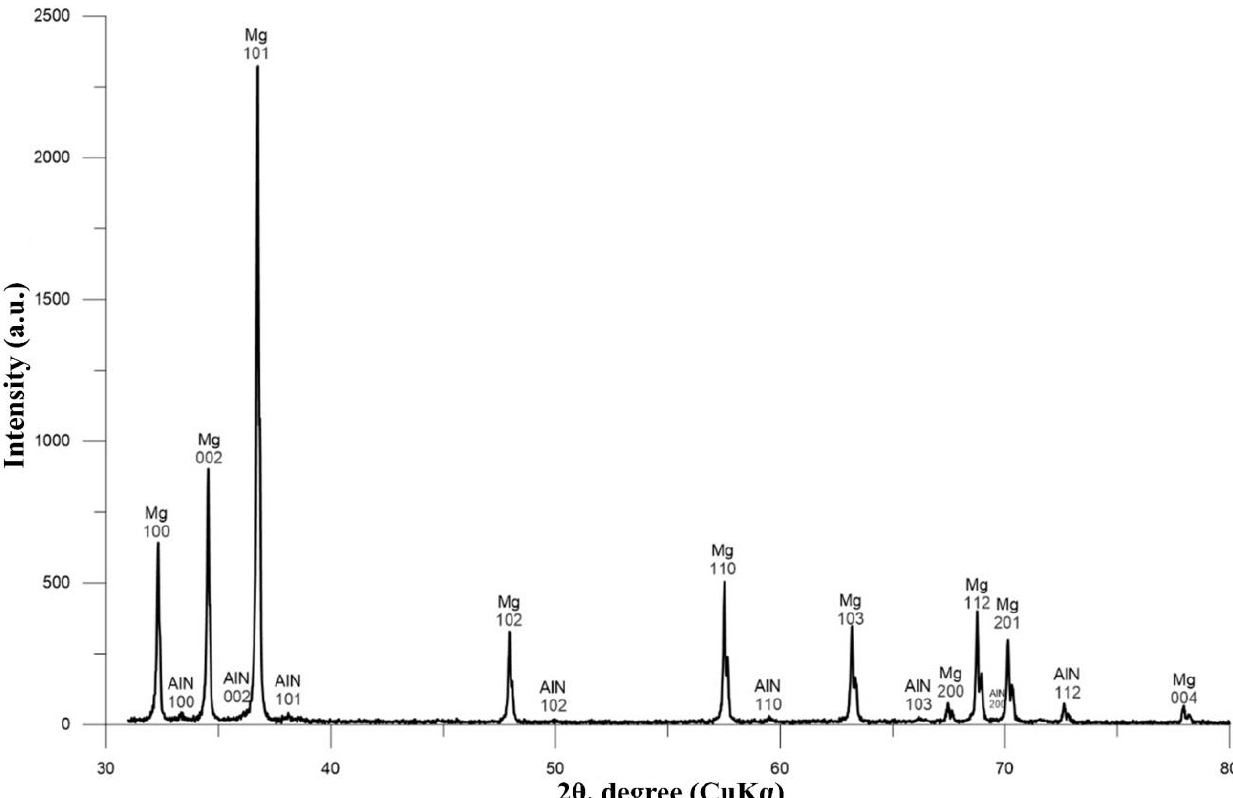
Figure 5. XRD pattern of the Mg – AlN master-alloy. Table 1. Phase and structural parameters of the Mg – AlN master-alloy. Phase Phase Content, wt.% Ǻ